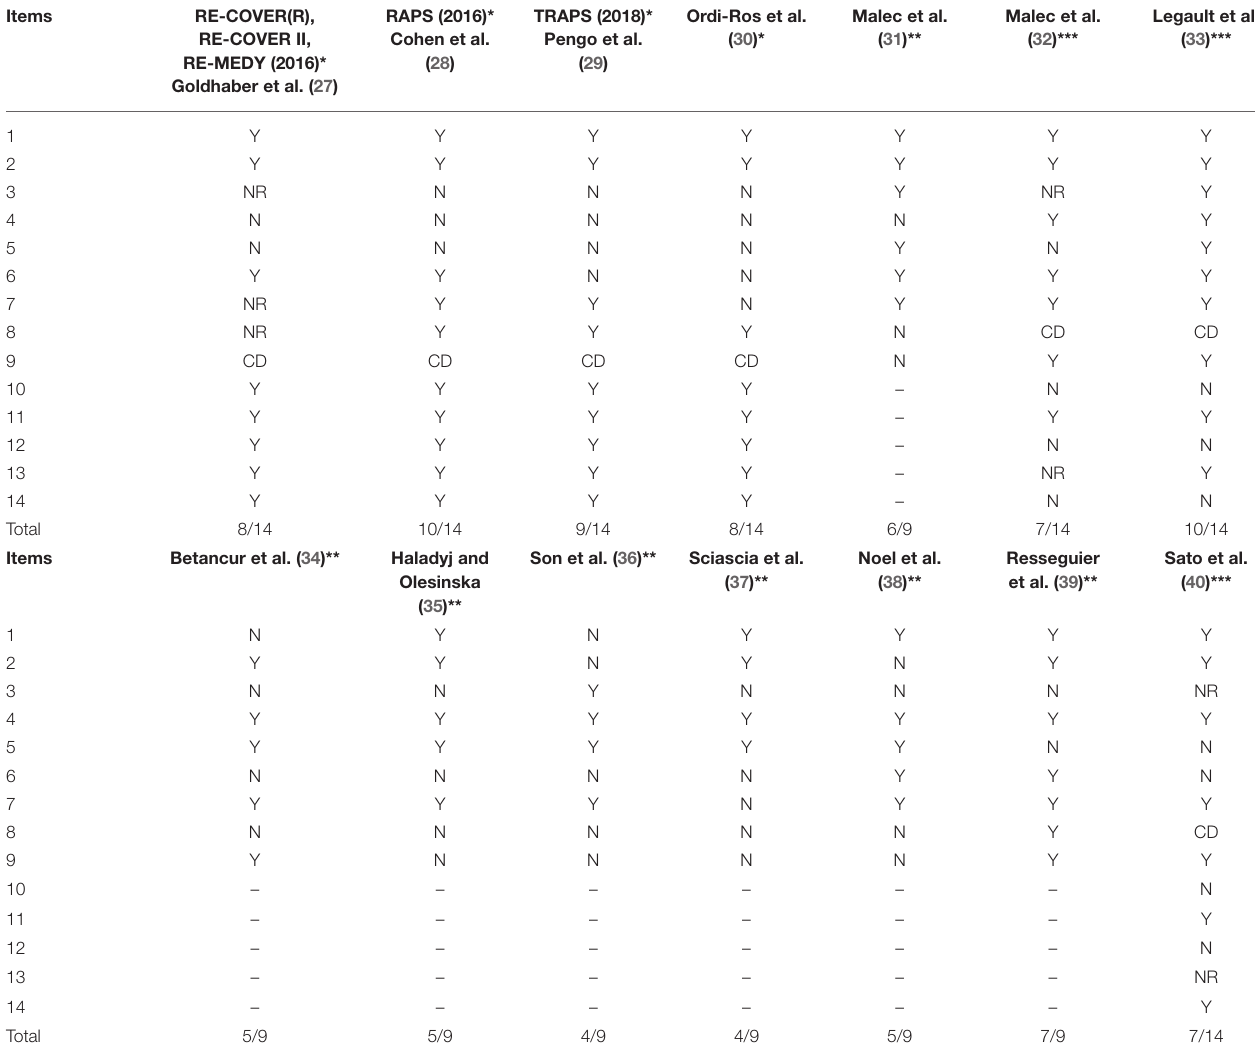
TABLE 1 | Quality assessment for included studies.